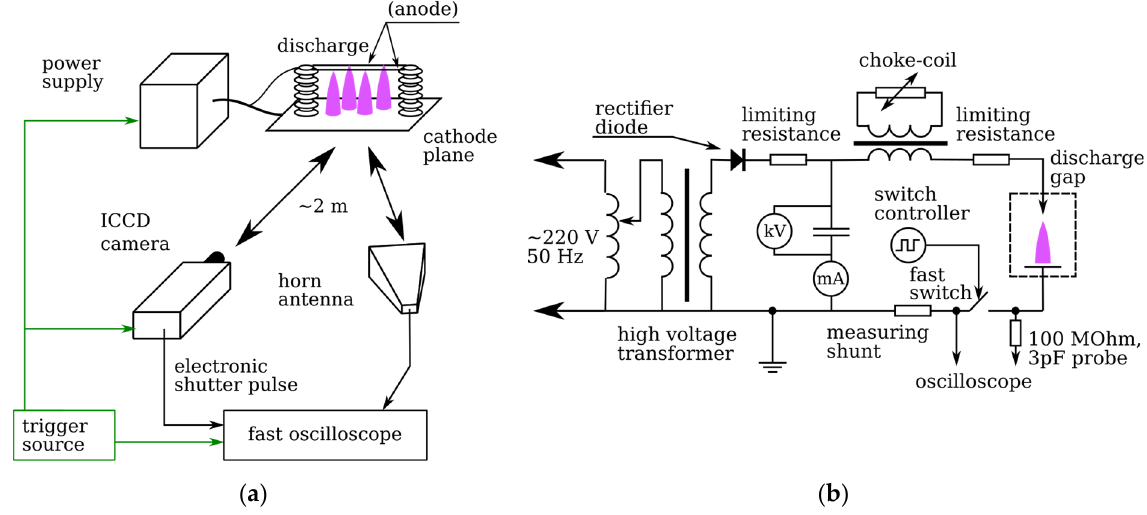
Figure 1. Experimental setup. ( a ) Block diagram of the setup. ( b ) Block diagram of the power supply of the high-voltage discharge.